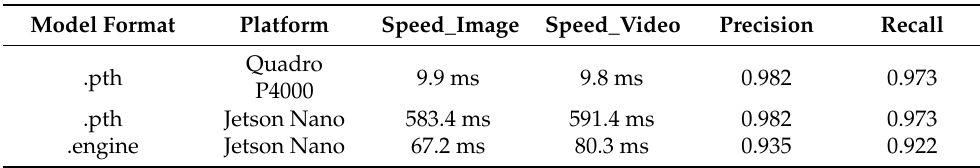
Table 3. Model test effect